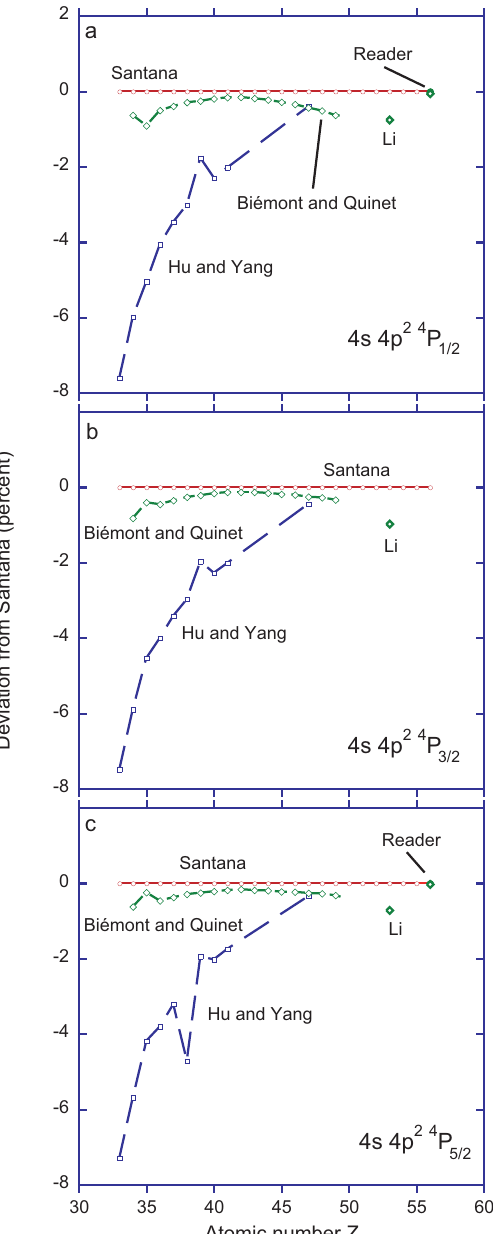
Figure 8. Deviation of the 4s4p 2 4 P J levels in Ga-like ions ( a ) J =1/2, ( b ) J =3/2 and ( c ) J =5/2 from the MRMP computational results obtained by Santana [13] (open circles at the zero line). These computational results are close to the results obtained by Biémont and Quinet [69], who adjusted their HXR computational results semi-empirically to the trend of the experimental data. The MCDF results by Hu and Yang [96] clearly deviate from experiment at low Z and approximate the latter only for higher values of Z . Li [57] denotes MCDF computations, as well, while Reader [98] represents experimental